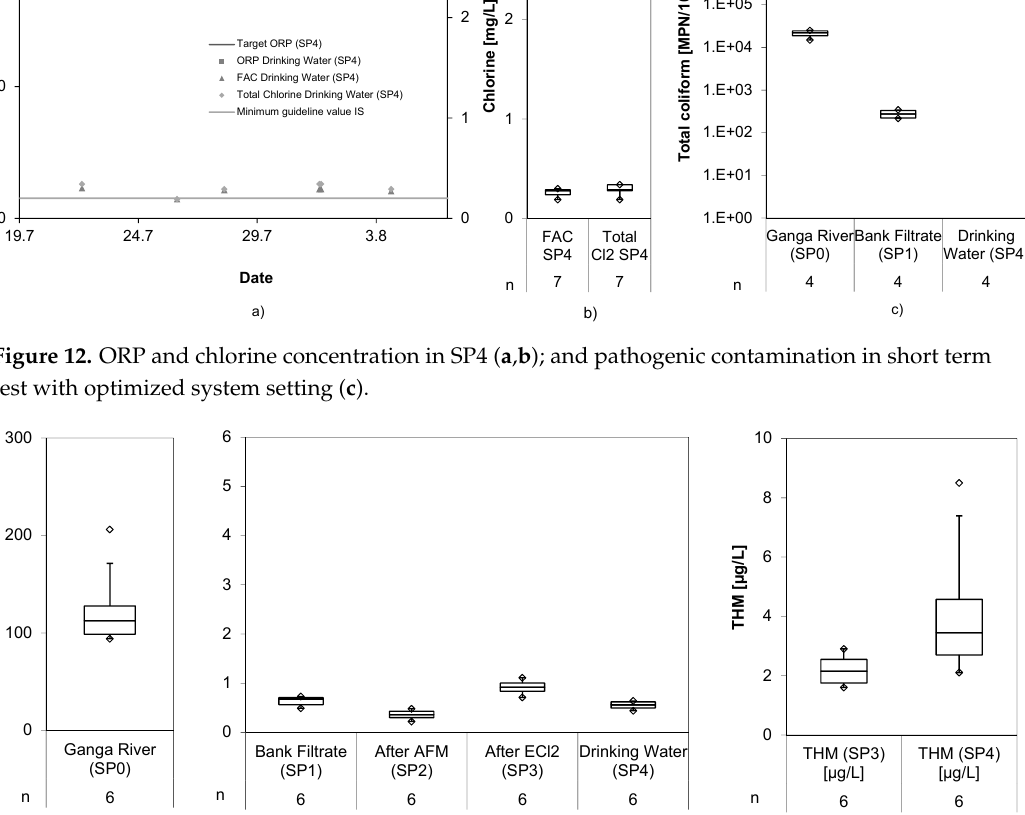
Figure 12. ORP and chlorine concentration in SP4 ( a , b ); and pathogenic contamination in short term test with optimized system setting ( c ).